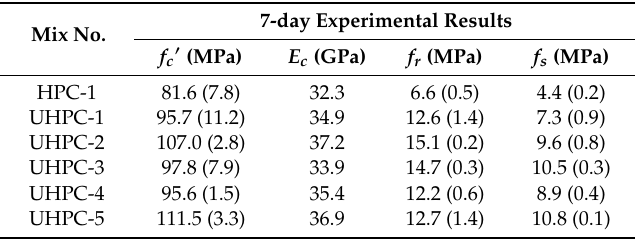
Table 8. Results of hardened concrete properties at room temperature.